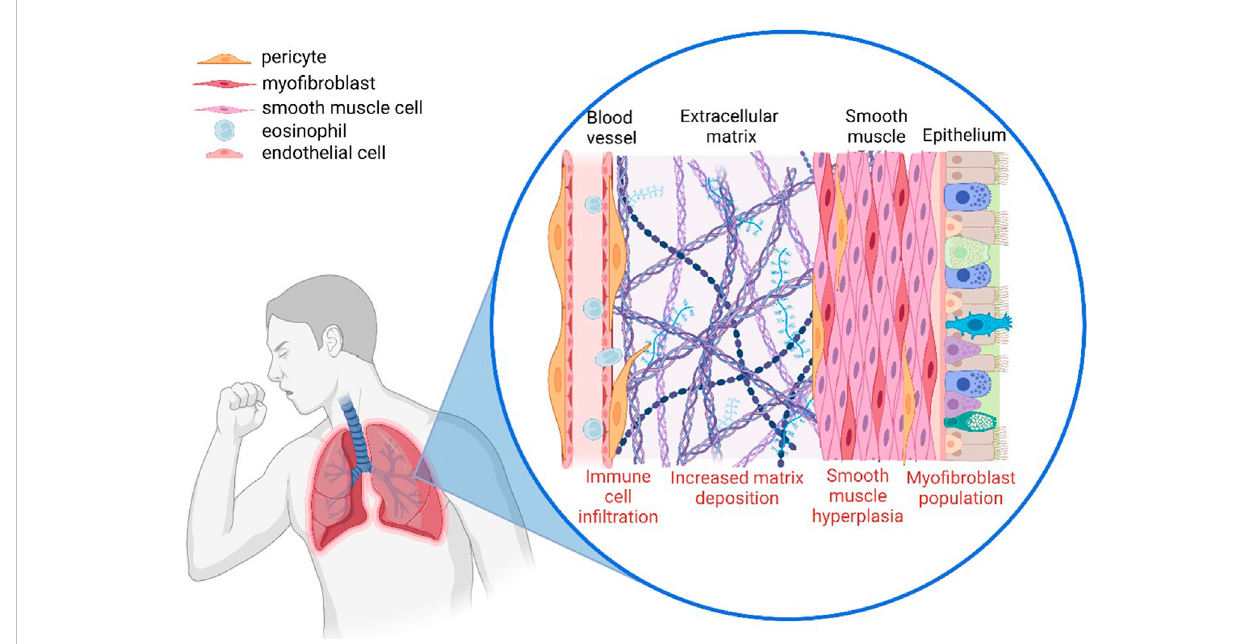
The involvement ofpericytes inthe airway remodelling observed in asthmaticlungs. Pericytes modulateimmunein fi ltration, detach from theblood vessel and migrate towards the site of in fl ammation where they increase deposition of extracellular matrix components, and also contribute to vascular leakage (Created with